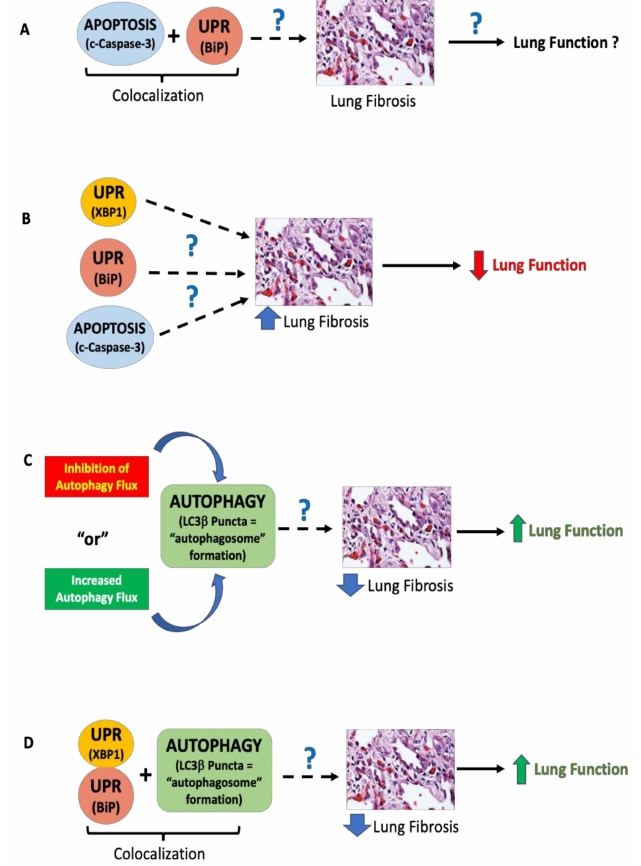
Figure 4. Five testable hypotheses regarding the relative contributions of UPR, apoptosis, and autophagy to pulmonary fibrosis and lung function changes. The confocal and linear correlation data presented in Figures 1–3 highlight critical connections linking cell stress biology, lung fibrosis, and the resultant lung function changes in patients that lead to debilitating symptoms. ( A ) Co-localization of cleaved caspase-3 and BiP was significantly greater in IPF lungs than non-IPF lungs, but the causal link to lung fibrosis and lung function remains unknown. ( B ) UPR markers XBP1 and BiP and apoptosis marker cleaved caspase-3 were independently associated with lower lung function in IPF, but the cross-talk between these pathways remains incompletely understood. ( C ) The increase in autophagosome formation (i.e., increased expression of LC3 β puncta) could represent either active autophagy flux or the inhibition of autophagy flux. Our data show that autophagy is definitely involved and correlates with improvement in the lung function parameter (i.e., improvement in DLCO); however, the directionality of autophagy remains unknown. ( D ) Co-localization of UPR (XBP1, BiP) and autophagy (LC3 β puncta) was associated with higher lung function; however, the mechanism of this observation is not yet known. Our data suggest that within the context of active UPR in IPF lungs, the presence of autophagy changes the consequence of UPR and leads to higher lung function. Whether this occurs via the inhibition or activation of autophagy flux remains unknown. The results from Figures 1 and 2, depicted graphically in Panels A and B , lead to Hypothesis 1. Cross-talk and dysregulation between apoptosis and UPR pathways cause lung fibrosis, which leads to progressive loss of lung function. The results from Figures 2 and 3, depicted graphically in Panels C and D , lead to the following four hypotheses: Hypothesis 2a. Autophagy inhibition reduces lung fibrosis, which, in turn, preserves or improves lung function. Hypothesis 2b. Autophagy activation reduces lung fibrosis, which, in turn, preserves or improves lung function. Hypothesis 3a. Within the context of active UPR (XPB1 and BiP), the inhibition of autophagy reduces lung fibrosis, which improves lung function. Hypothesis 3b. Within the context of active UPR (XPB1 and BiP), the activation of autophagy reduces lung fibrosis, which improves lung function. Note: Dotted line arrows indicate multiple intervening steps not shown. Solid line arrows indicate a direct effect of lung fibrosis on lung